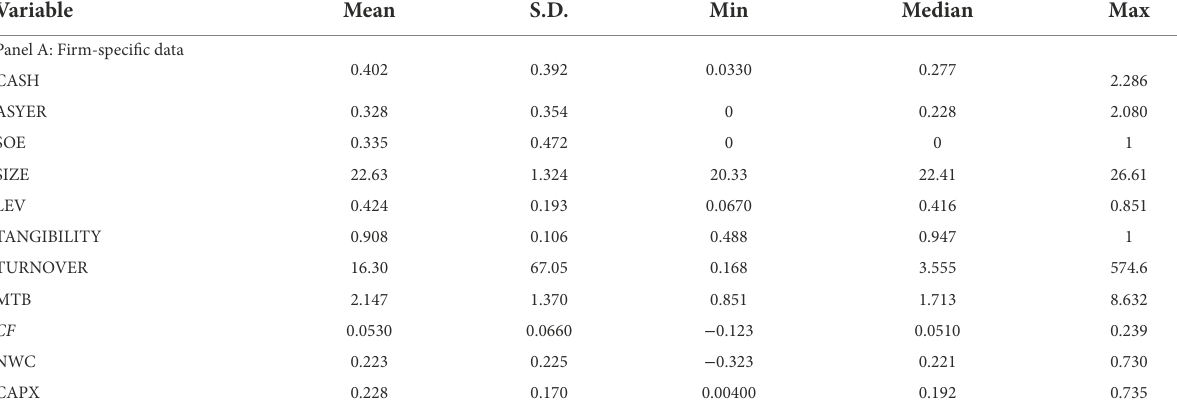
TABLE 2 Summary of the statistics. Variable